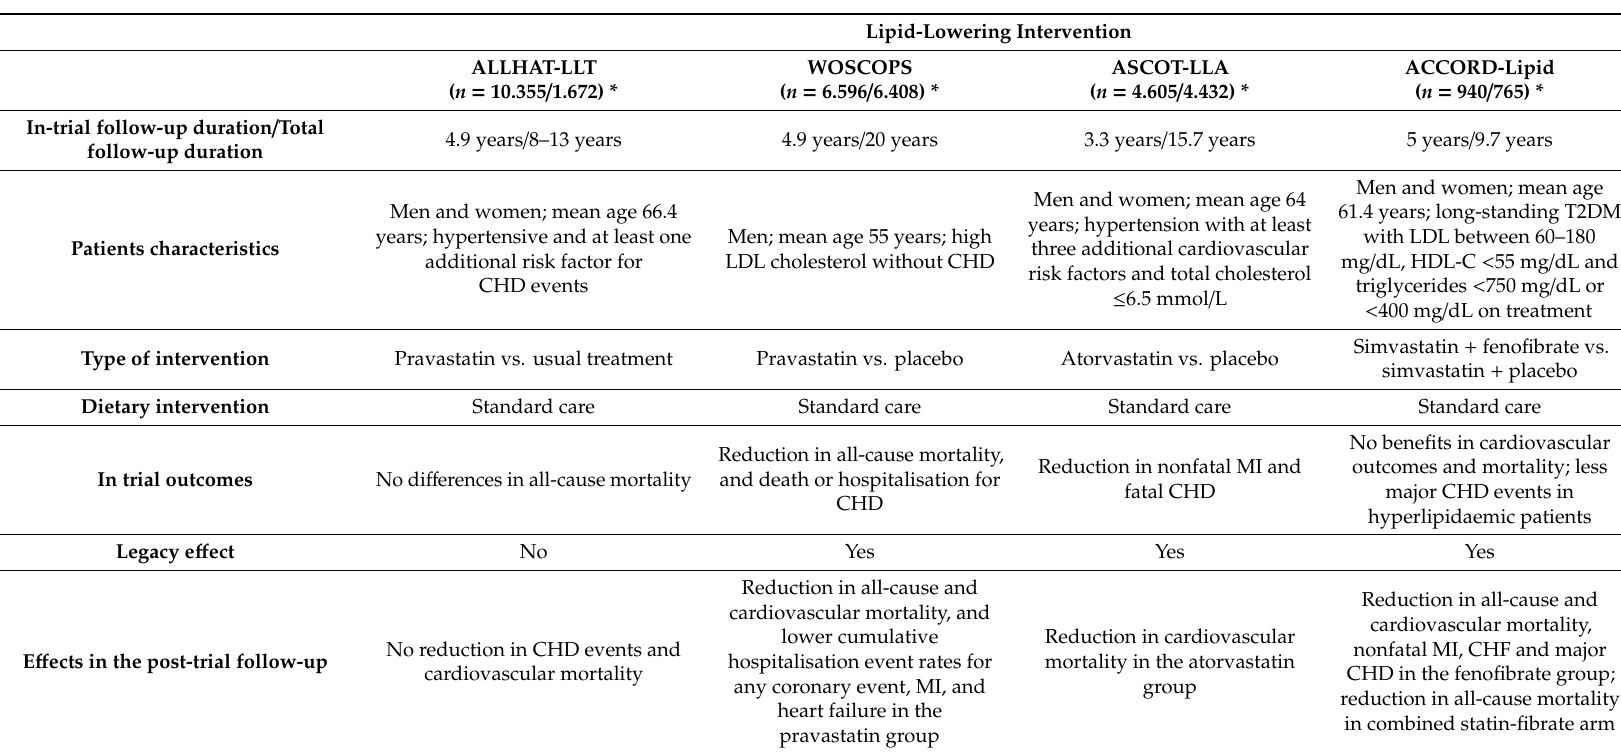
Table 3. Studies assessing the legacy e ff ect after lipid-lowering